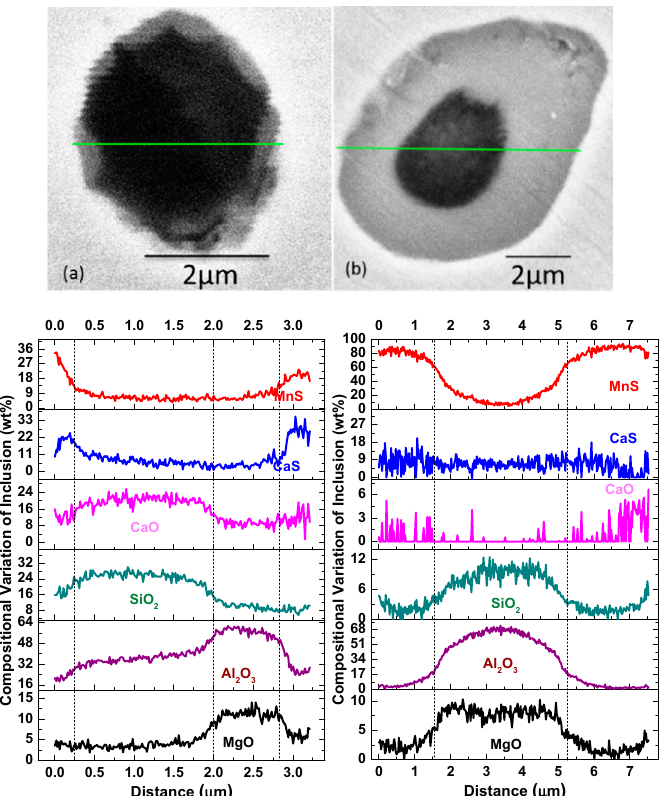
Figure 3. Proportion of three types of inclusions in each experiment. The composition distribution of oxides in Type-1 inclusions is displayed in Figure 4. It can be seen that the oxides were rich in Al 2 O 3 and there were not many liquid oxides during the continuous casting process. The average CaO content in inclusions for high Ca-containing experiments (Experiments 1 and 3) was higher than that for low Ca-containing experiments (Experiments 2 and 4). The average MgO content in inclusions for Experiment 1 was higher than Experiment 2, and that for Experiment 3 was lower than Experiment 2. This is probably due to the floatation of inclusion into